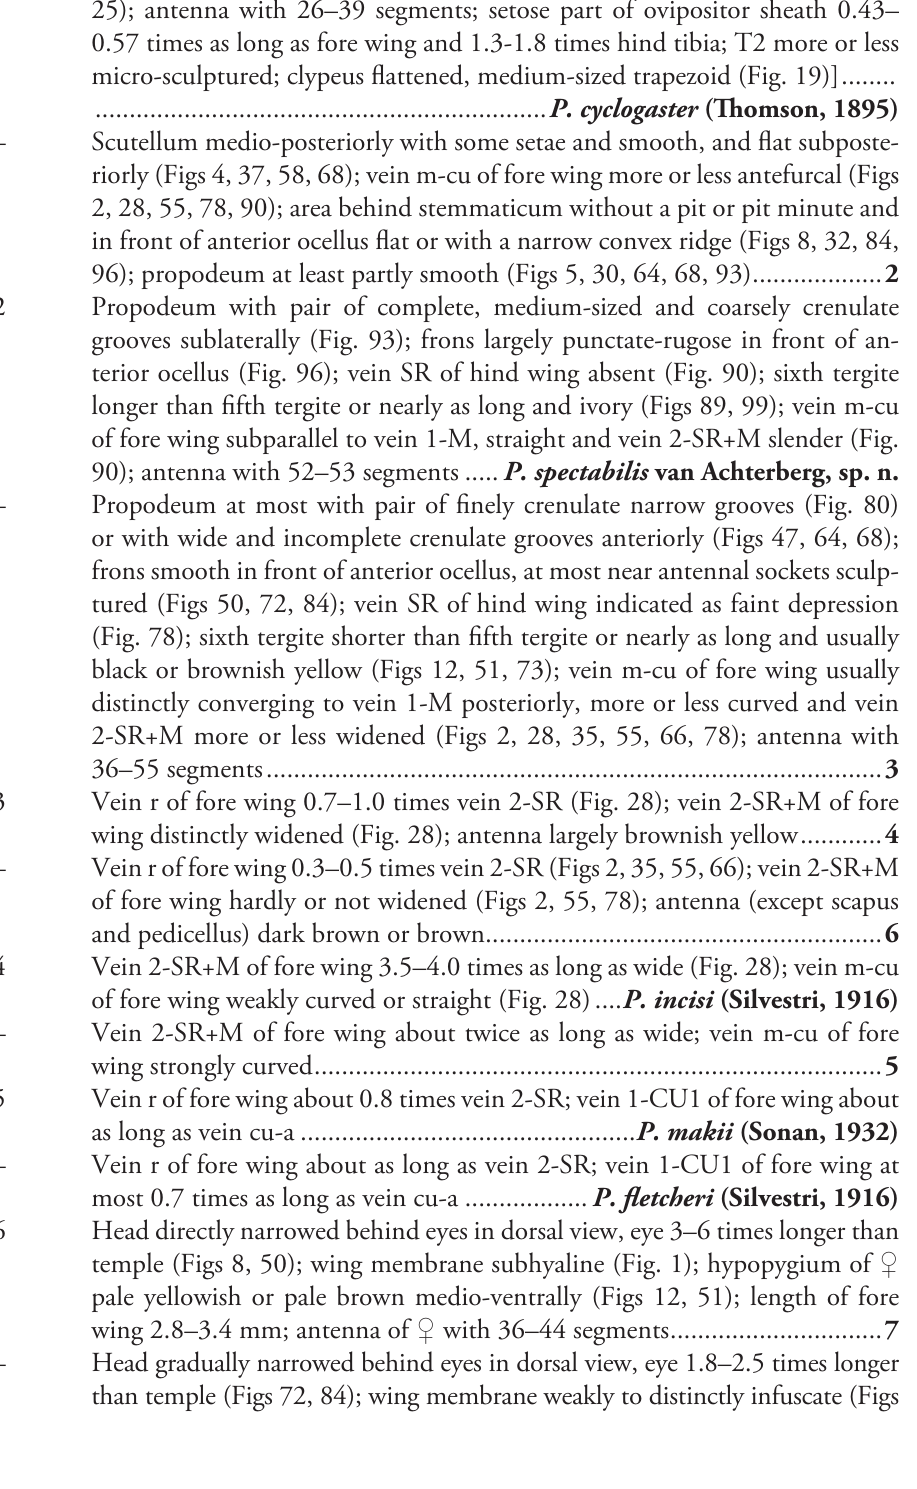
25); antenna with 26–39 segments; setose part of ovipositor sheath 0.43– 0.57 times as long as fore wing and 1.3-1.8 times hind tibia; T2 more or less micro-sculptured; clypeus flattened, medium-sized trapezoid (Fig. 19)] ........ – Scutellum medio-posteriorly with some setae and smooth, and flat subposte- riorly (Figs 4, 37, 58, 68); vein m-cu of fore wing more or less antefurcal (Figs 2, 28, 55, 78, 90); area behind stemmaticum without a pit or pit minute and in front of anterior ocellus flat or with a narrow convex ridge (Figs 8, 32, 84, 96); propodeum at least partly smooth (Figs 5, 30, 64, 68, 93) ................... 2 2 Propodeum with pair of complete, medium-sized and coarsely crenulate grooves sublaterally (Fig. 93); frons largely punctate-rugose in front of an- terior ocellus (Fig. 96); vein SR of hind wing absent (Fig. 90); sixth tergite longer than fifth tergite or nearly as long and ivory (Figs 89, 99); vein m-cu of fore wing subparallel to vein 1-M, straight and vein 2-SR+M slender (Fig. 90); antenna with 52–53 segments ..... P. spectabilis van Achterberg, sp. n. – Propodeum at most with pair of finely crenulate narrow grooves (Fig. 80) or with wide and incomplete crenulate grooves anteriorly (Figs 47, 64, 68); frons smooth in front of anterior ocellus, at most near antennal sockets sculp- tured (Figs 50, 72, 84); vein SR of hind wing indicated as faint depression (Fig. 78); sixth tergite shorter than fifth tergite or nearly as long and usually black or brownish yellow (Figs 12, 51, 73); vein m-cu of fore wing usually distinctly converging to vein 1-M posteriorly, more or less curved and vein 2-SR+M more or less widened (Figs 2, 28, 35, 55, 66, 78); antenna with 36–55 segments .......................................................................................... 3 3 Vein r of fore wing 0.7–1.0 times vein 2-SR (Fig. 28); vein 2-SR+M of fore wing distinctly widened (Fig. 28); antenna largely brownish yellow ............ 4 – Vein r of fore wing 0.3–0.5 times vein 2-SR (Figs 2, 35, 55, 66); vein 2-SR+M of fore wing hardly or not widened (Figs 2, 55, 78); antenna (except scapus and pedicellus) dark brown or brown .......................................................... 6 4 Vein 2-SR+M of fore wing 3.5–4.0 times as long as wide (Fig. 28); vein m-cu of fore wing weakly curved or straight (Fig. 28) .... P. incisi (Silvestri, 1916) – Vein 2-SR+M of fore wing about twice as long as wide; vein m-cu of fore wing strongly curved ................................................................................... 5 5 Vein r of fore wing about 0.8 times vein 2-SR; vein 1-CU1 of fore wing about as long as vein cu-a ................................................. P. makii (Sonan, 1932) – Vein r of fore wing about as long as vein 2-SR; vein 1-CU1 of fore wing at most 0.7 times as long as vein cu-a .................. P. fletcheri (Silvestri, 1916) 6 Head directly narrowed behind eyes in dorsal view, eye 3–6 times longer than temple (Figs 8, 50); wing membrane subhyaline (Fig. 1); hypopygium of ♀ pale yellowish or pale brown medio-ventrally (Figs 12, 51); length of fore wing 2.8–3.4 mm; antenna of ♀ with 36–44 segments ............................... 7 – Head gradually narrowed behind eyes in dorsal view, eye 1.8–2.5 times longer than temple (Figs 72, 84); wing membrane weakly to distinctly infuscate